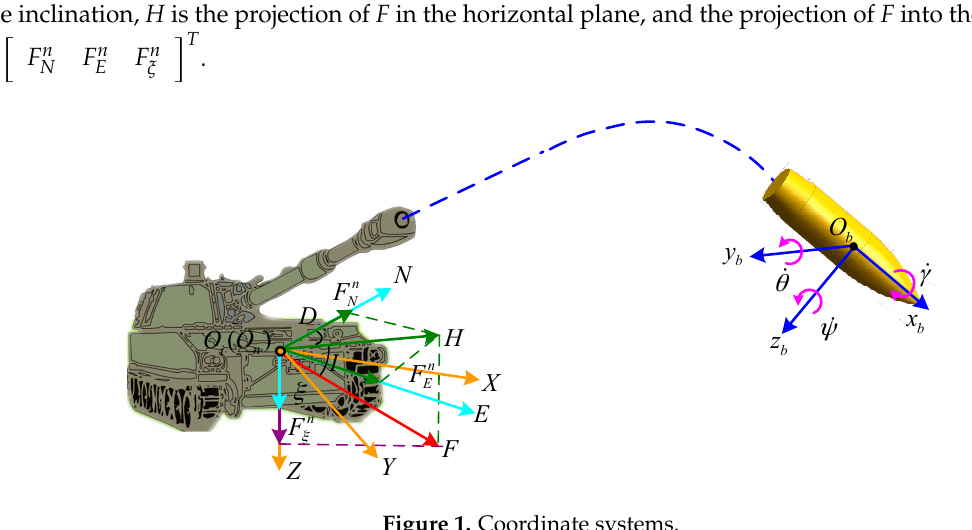
Figure 1. Coordinate systems.